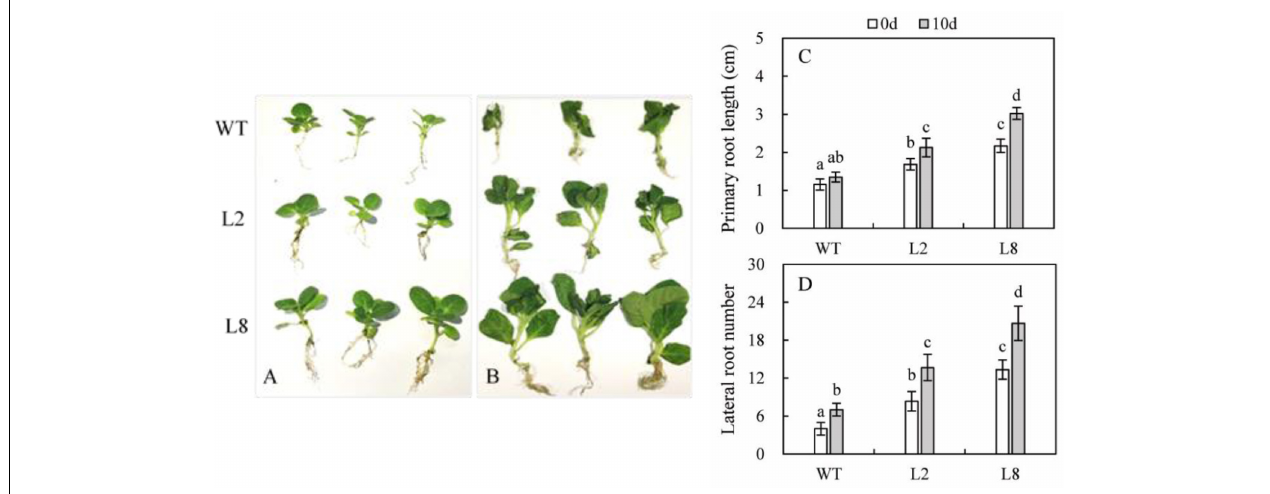
FIGURE 3 | Effect of overexpression of SoCYP85A1 on root development before and after drought stress. Phenotypes of seedlings at 6-week-old under the normal conditions (A) and water loss for 10 d (B) . Primary root length (C) and lateral root number (D) of seedlings at 6-week-old with and without water. Error bars represent SD and values with different letters are significant at P <